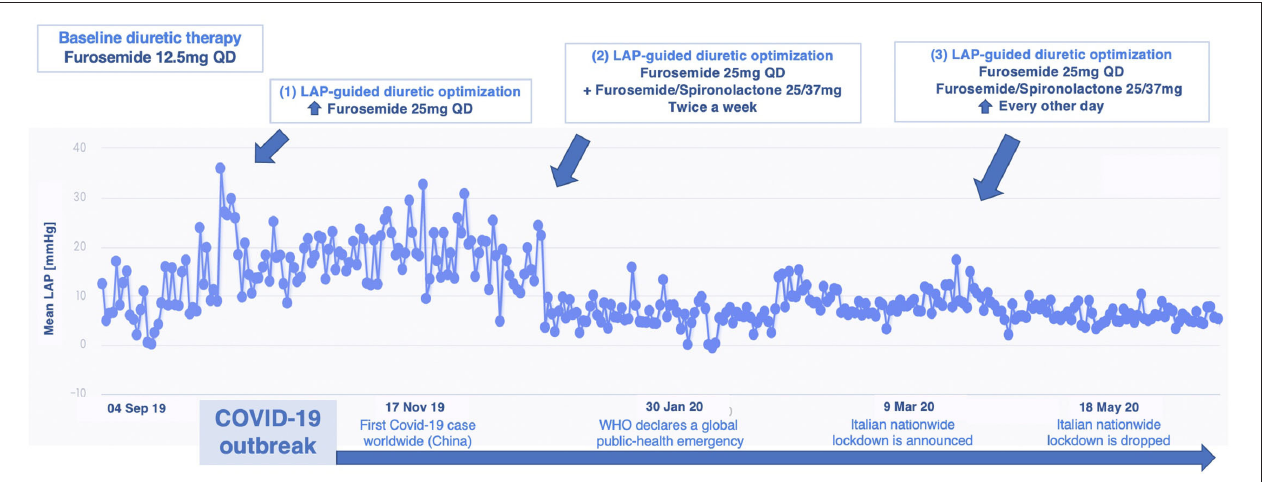
FIGURE 2 | Remote LAP-guided therapy optimization over 12 months from VLAP TM implantation in patient 1: upper, therapy adjustments are reported; lower, milestones from the first coronavirus disease 2019 (COVID-19) wave are indicated. LAP, left atrial pressure; WHO, World Health Organization; QD, once daily.